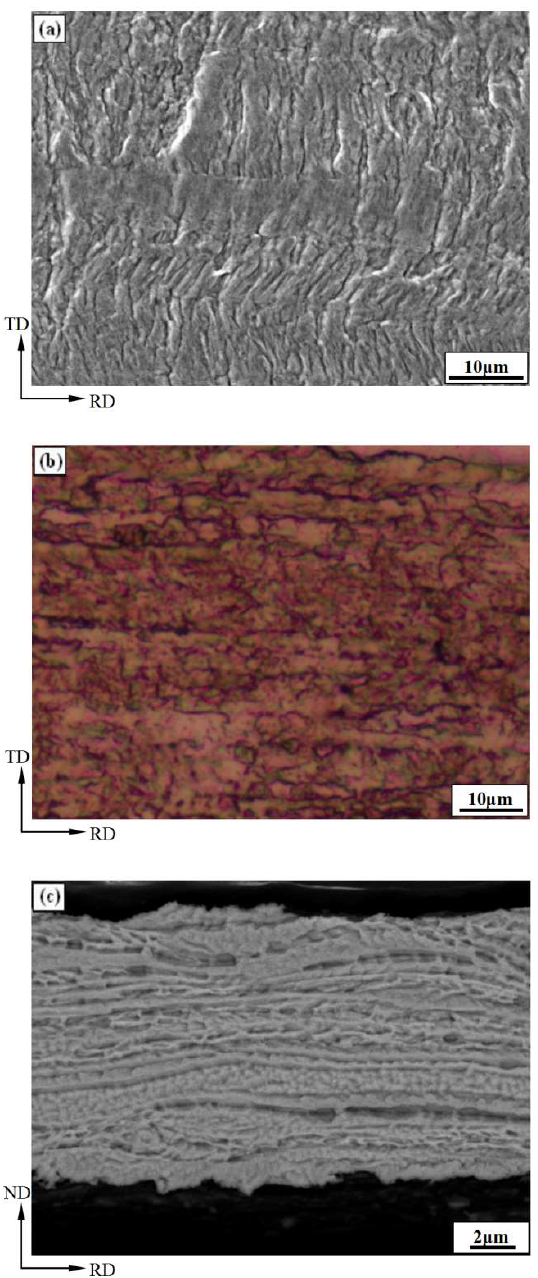
Figure 1. Morphology of copper foil surface and longitudinal section. ( a ) Surface morphology (SEM); ( b ) Surface morphology after corrosion (OM); ( c ) Longitudinal section morphology (SEM).